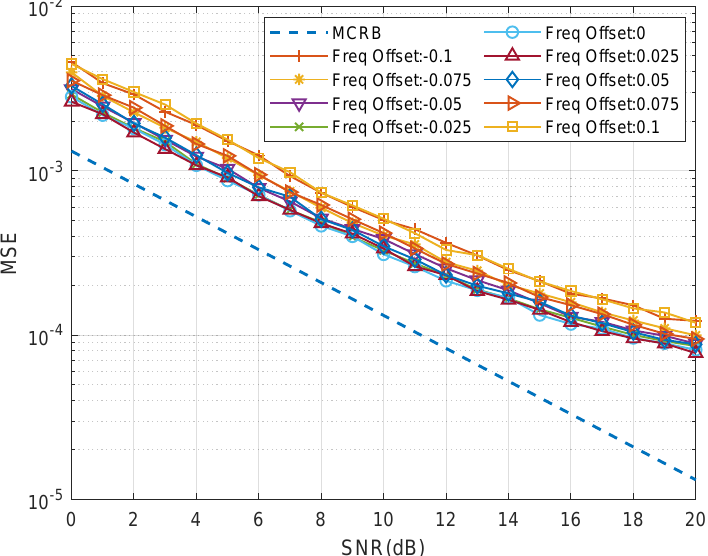
Figure 9. Timing estimation accuracy under different frequency